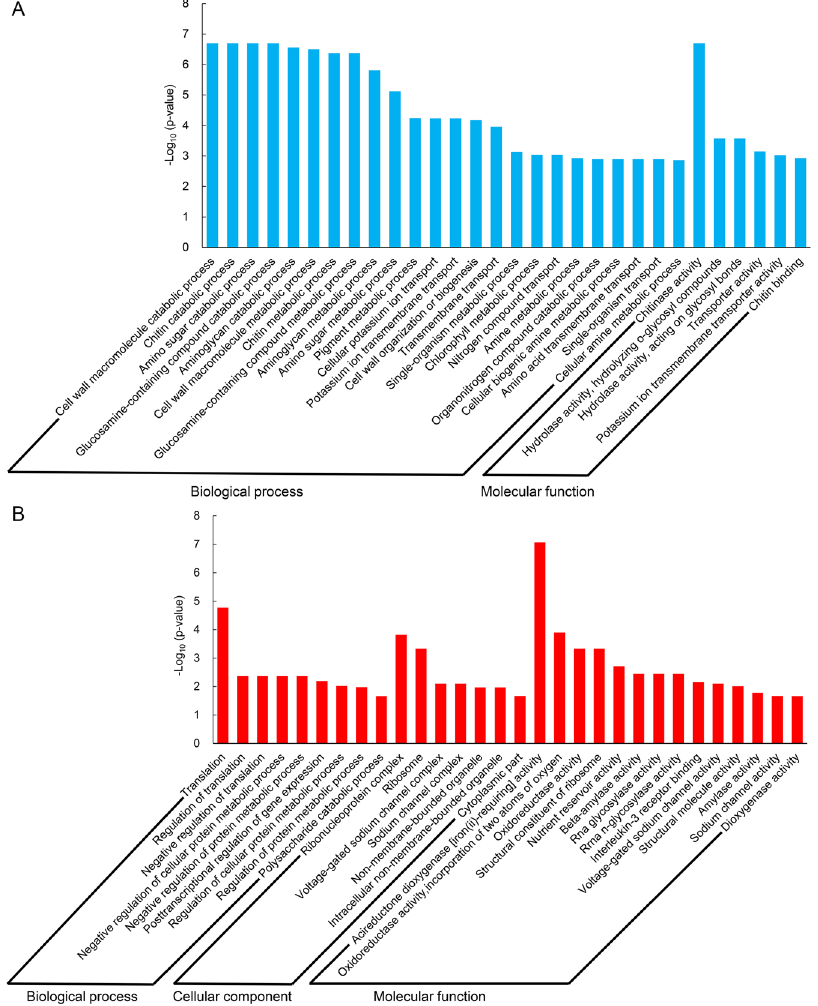
Figure 4. Significantly enriched Gene Ontology (GO) terms (p < 0.05) in B8 VS A8. A8: N0 seeds at 8 HAI. B8: N240 seeds at 8 HAI. ( A ) GO terms for the down regulated genes. ( B ) GO terms for the up regulated genes. GO terms were sorted based on